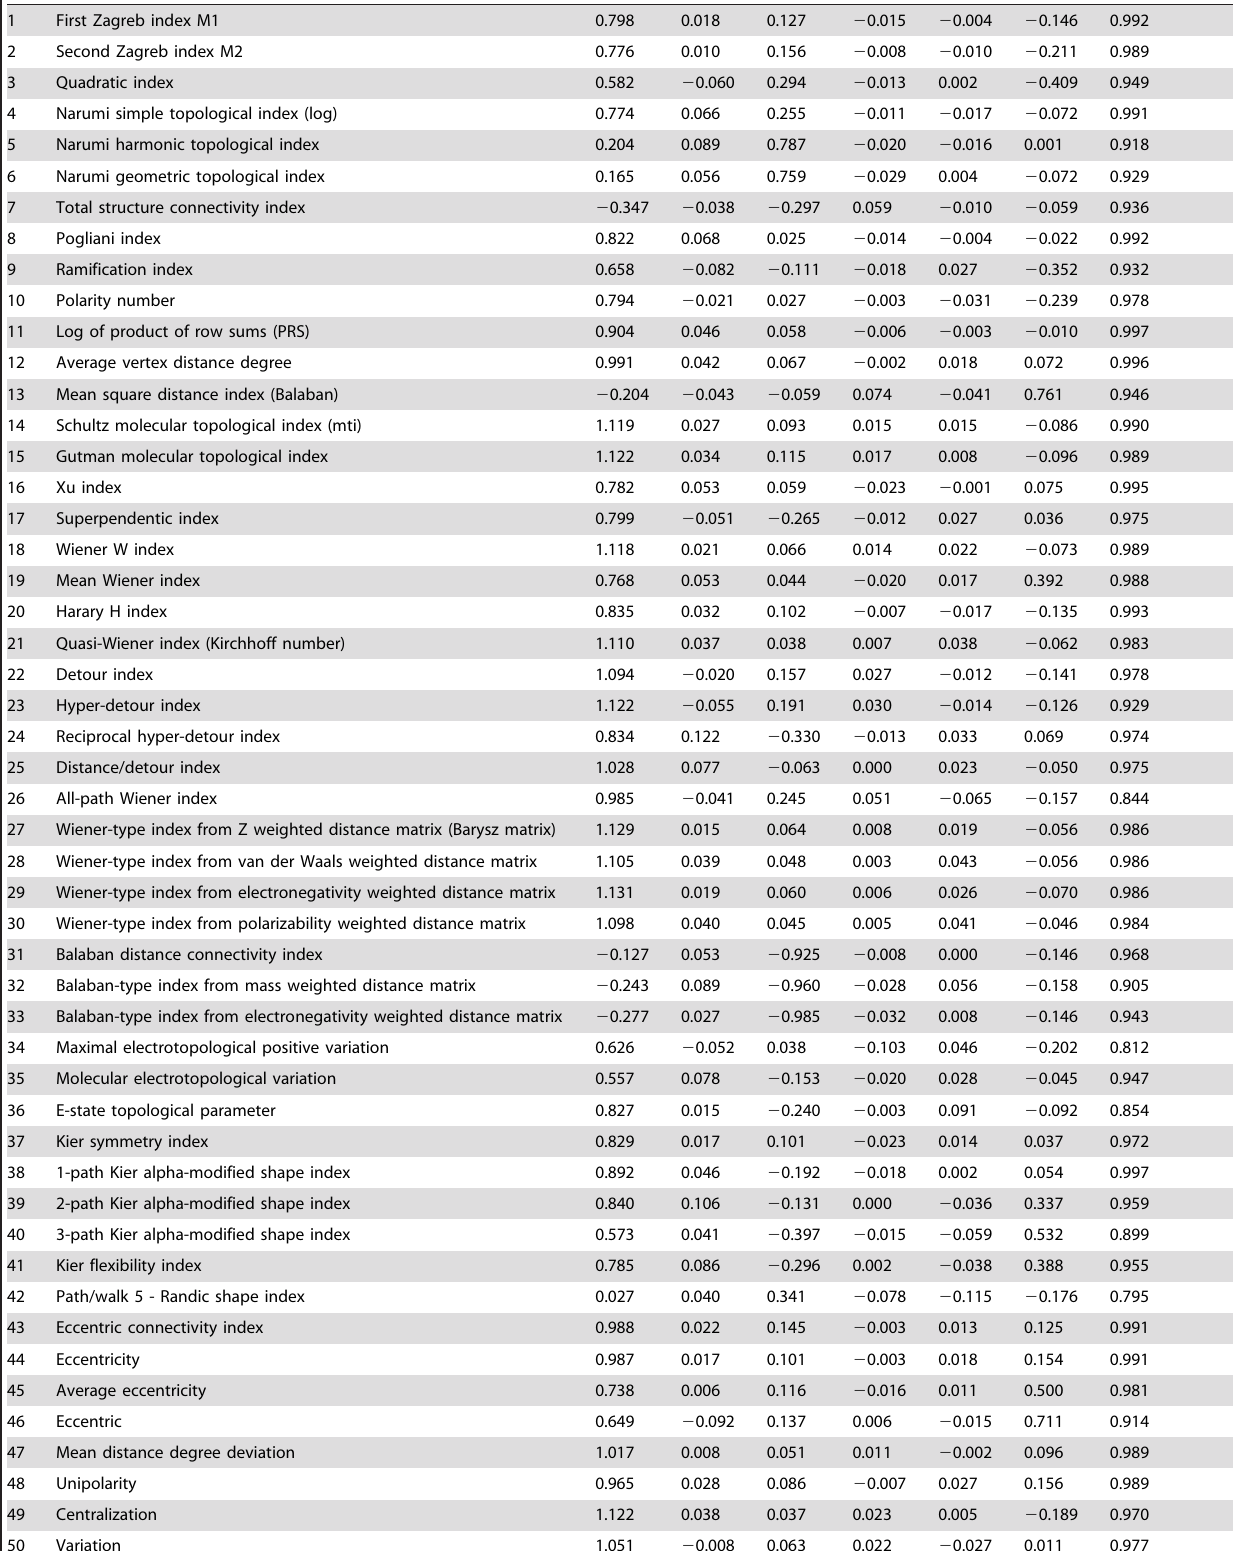
Table 1. Loading and communality of 155 variables on 6